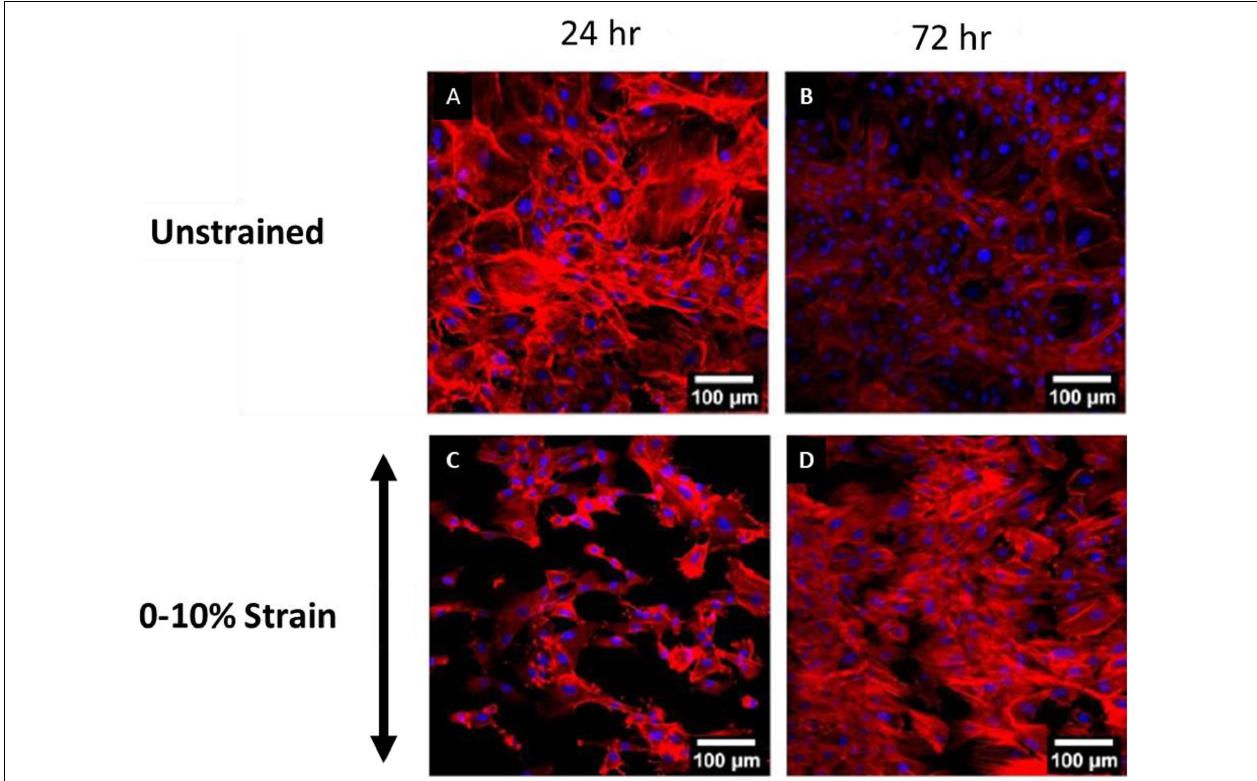
FIGURE 1 | Images of RASMC cultured on PDMS after 24 h (A,C) and 72 h (B,D) of no strain (A,B) or 0–10% 1 Hz cyclic tensile strain (C,D) . Blue—DAPI nuclei, Red—Phalloidin f-actin (Mathieu,